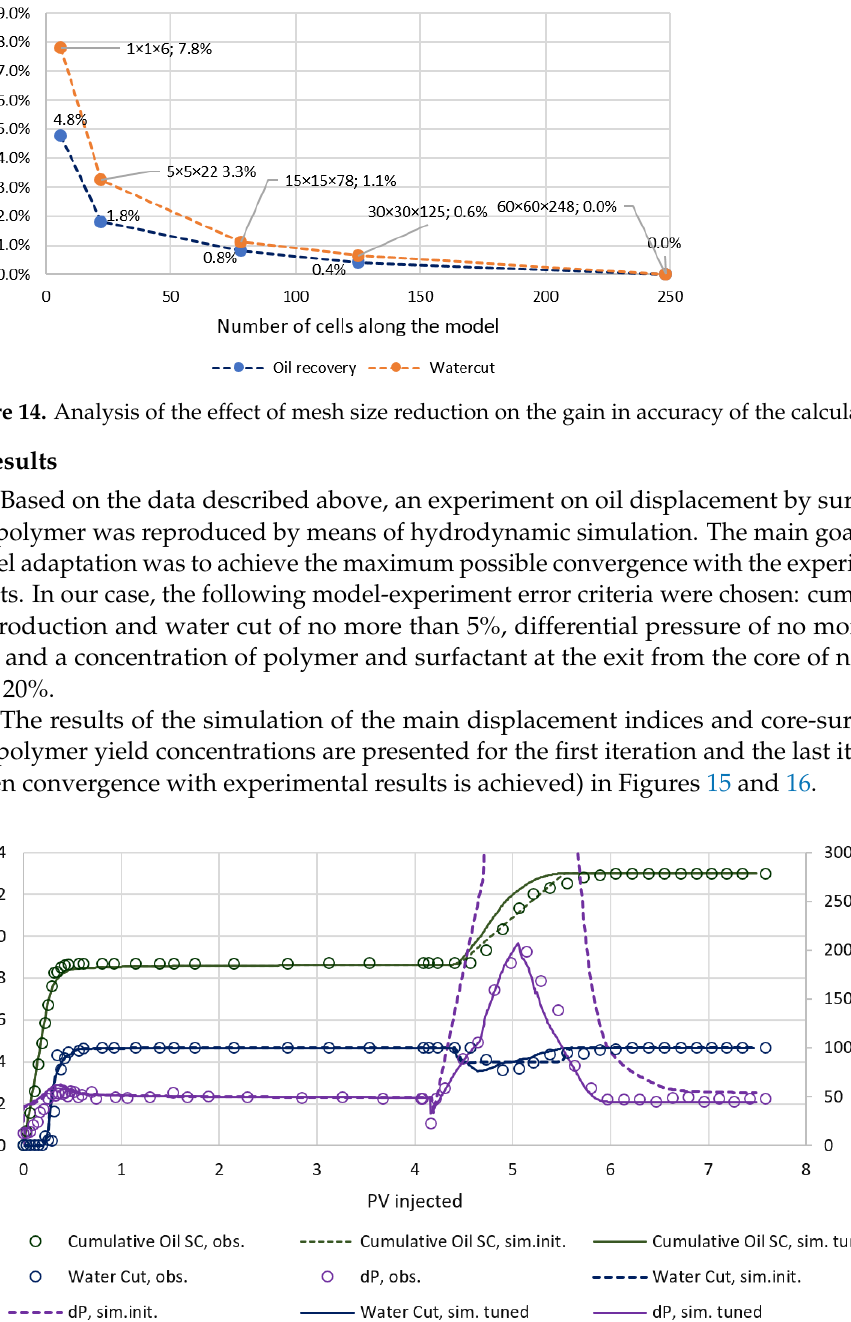
Figure 16. Result of model tuning to experimental data (surfactant and polymer yields). As a result of the adaptation of the model, it was possible to reproduce all the indi- cators of the experiment within the specified error, so the results obtained during the sim- ulation can be considered satisfactory. In the process of iterative tuning of the model, the main parameters of uncertainty were refined when describing the physics of the process of oil displacement by surfactants and polymers, which were not studied experimentally. The uncertain parameters obtained in the experiment and refined in the course of model tuning described earlier are shown in Table 5 and in Figures 17 and 18. Table 5. Parameters obtained by tuning the model to the experiment. Parameter